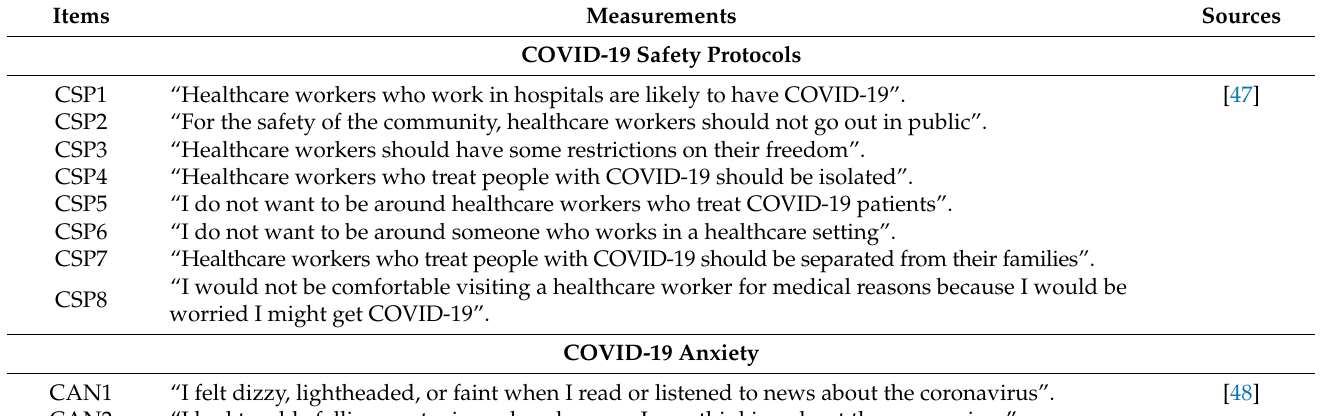
Table 2. Measurements of the